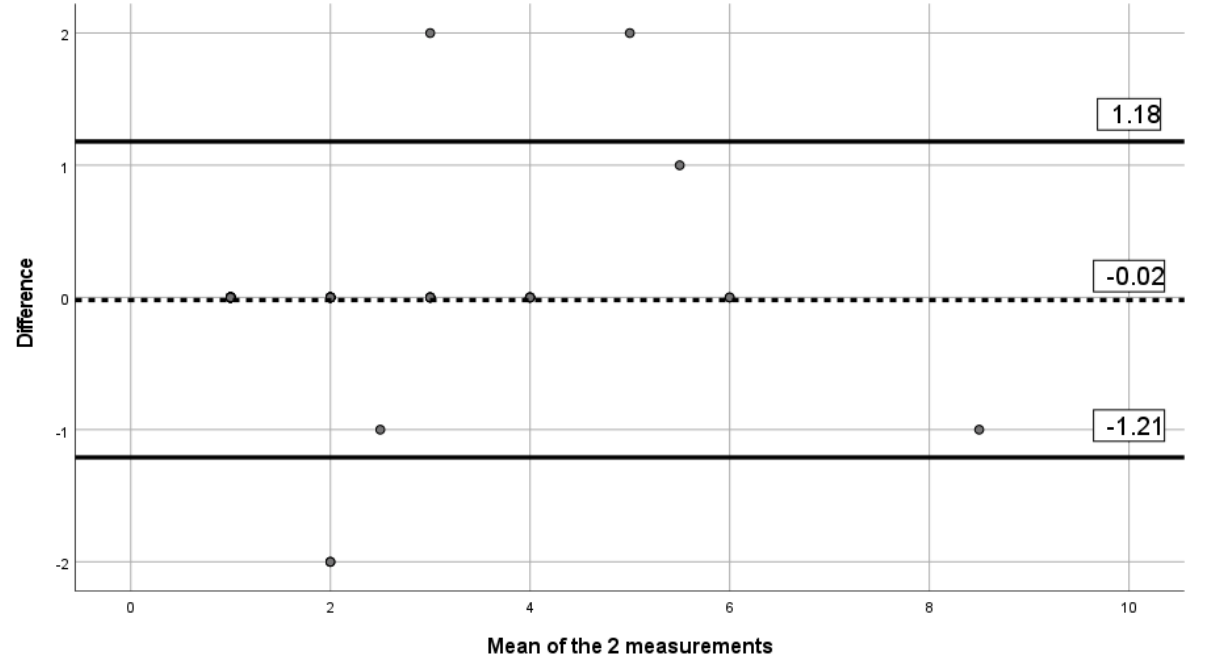
Figure 11. Bland-Altman limits for the number of painful body sites using the paper questionnaire and the mobile